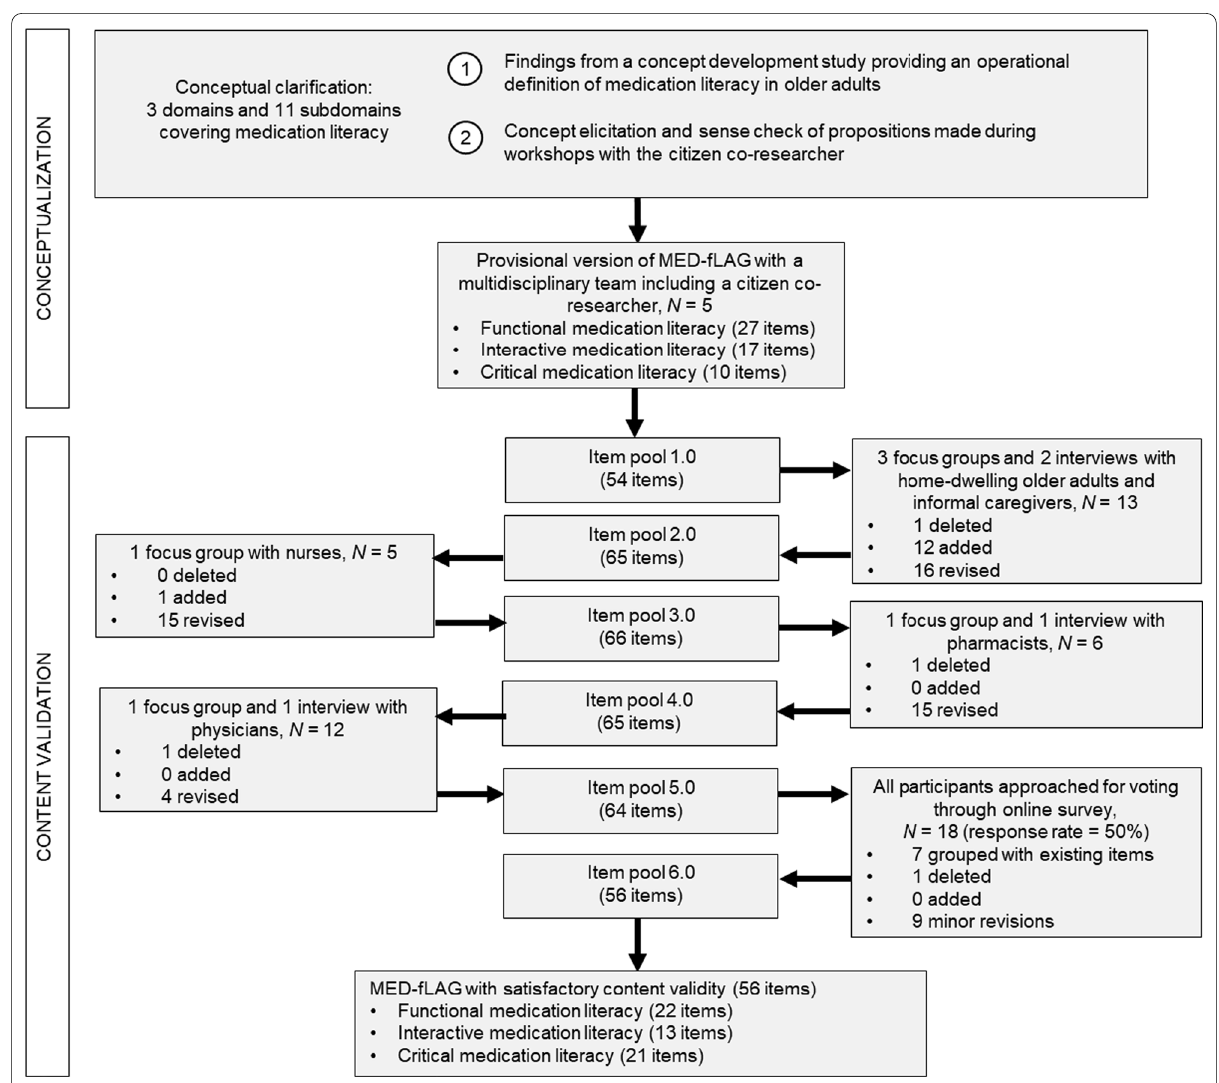
Fig. 2 Data collection process to establish the content validity of